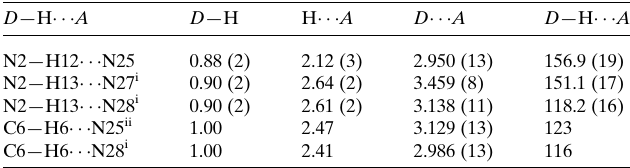
Table 1 Hydrogen-bond geometry (A˚ , (cid:4) ).